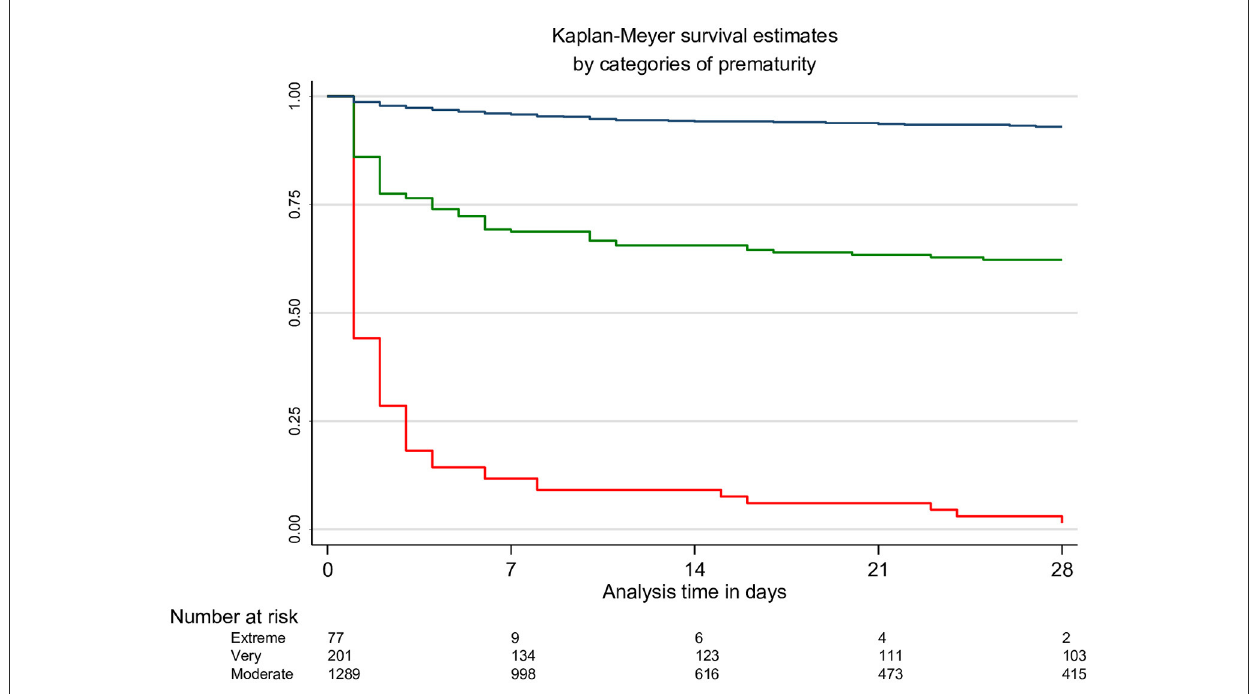
FIGURE2 Kaplan-Meyer survival estimates and number of neonates at risk table, by categories of prematurity. Red line: extreme preterm neonates (EGA < 28 weeks); green line: very preterm neonates (EGA 28–32 weeks); blue line: moderate preterm neonates (EGA 26–33